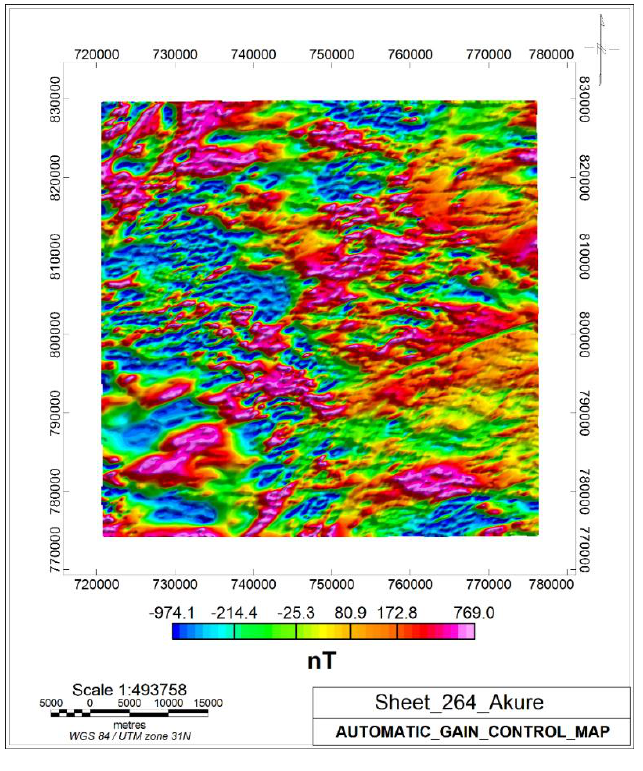
Figure 5: Automatic Gain Control (AGC) Image